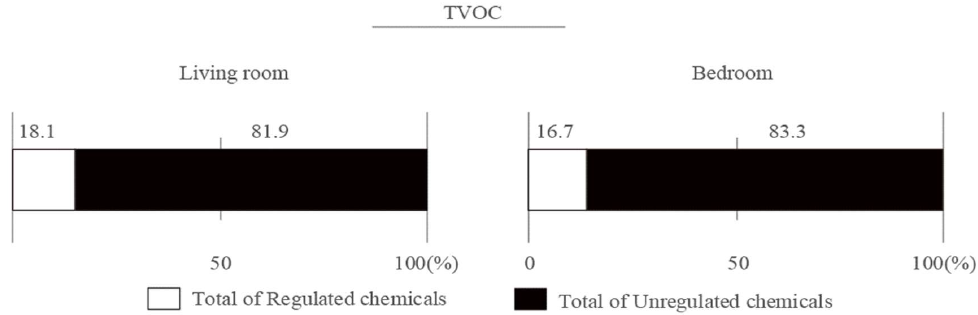
Figure 1. Proportions of regulated and unregulated compounds in the living rooms and bedrooms.